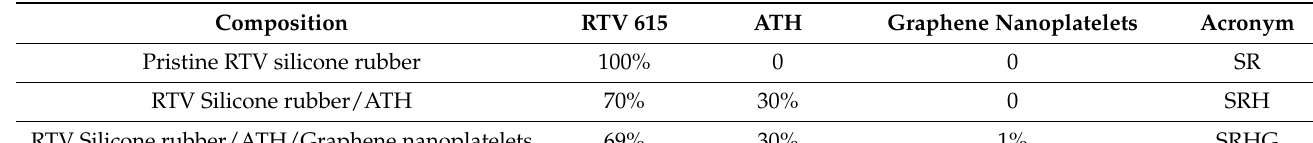
Table 1. Formulations used in this work.